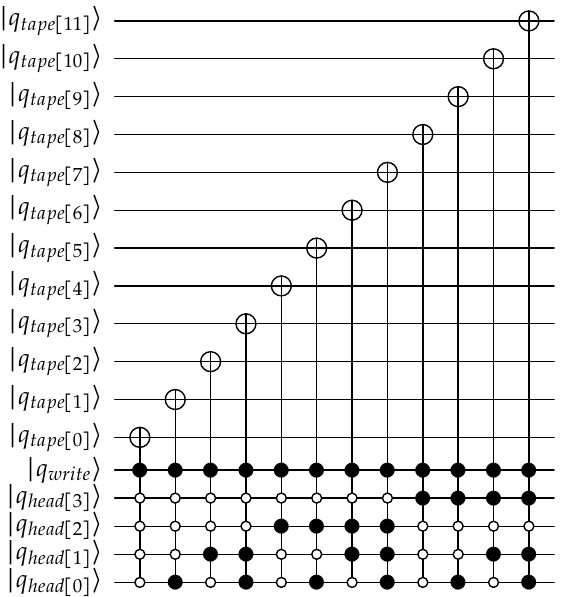
Figure A4. Write tape quantum circuit for QPULBA 2-2-1.